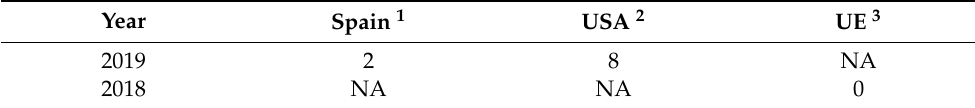
Table 1. Deaths in sewers, last full year with available